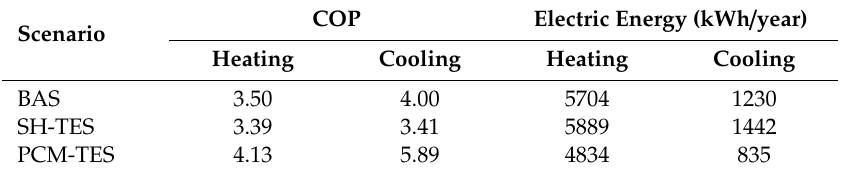
Table 3. Coe ffi cient of performance (COP) and yearly electricity consumption of each